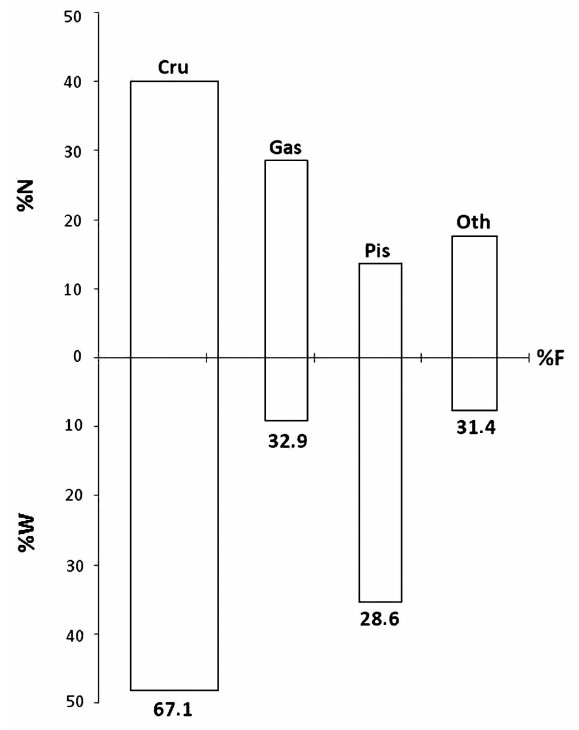
Fig . 11. – The frequency of occurrence (%F), percent number (%N) and weight (%W) for the major prey groups in the diet of Labrus mixtus from the central Adriatic Sea: Cru, crustaceans; Gas, gastro- pods; Pis, fishes; Oth,